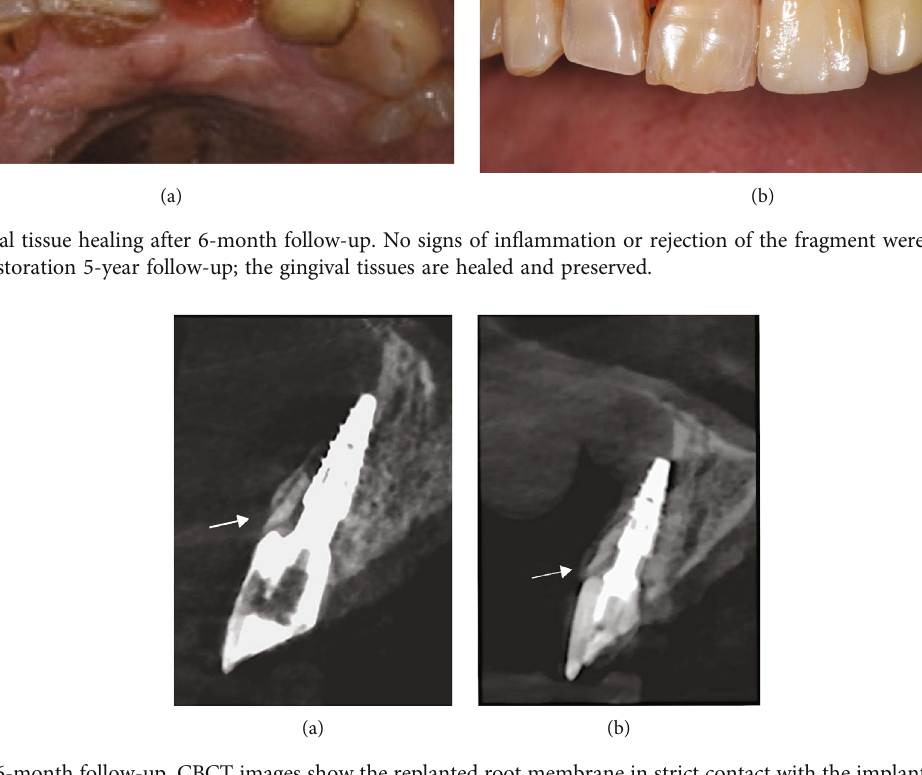
Figure 3: (a) At 6-month follow-up, CBCT images show the replanted root membrane in strict contact with the implant abutment and the bundle bone. The arrow indicates the portion of root not covered by bone. (b) At 48 months, CBCT images are compatible with the complete covering of the root membrane (see the arrow), as if there had been migration of the bone over all the root membrane